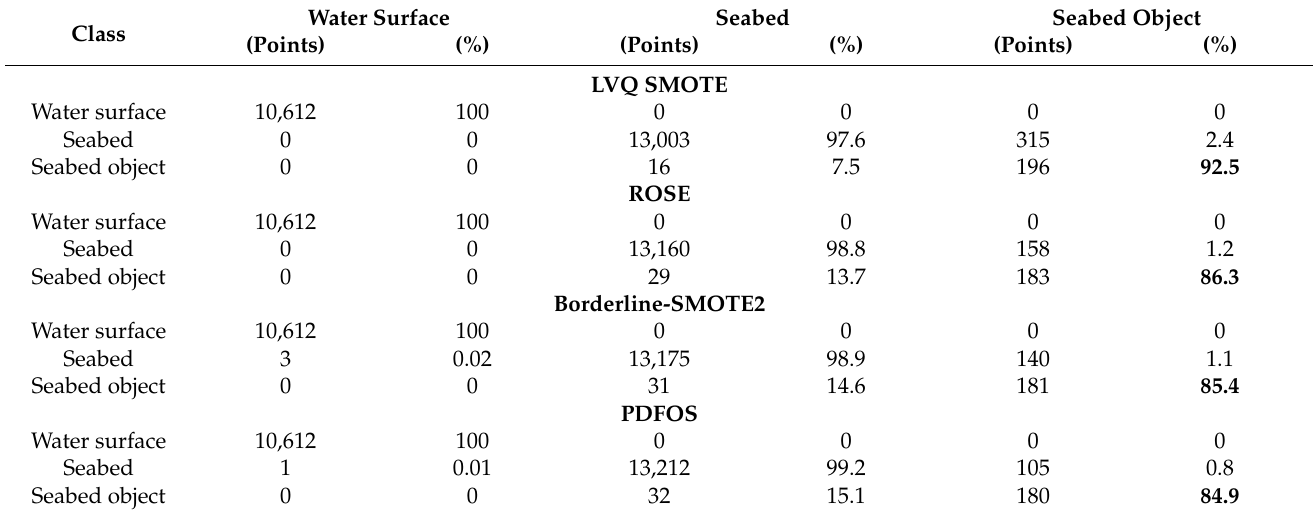
Table 6. Confusion matrix for the algorithms with the highest